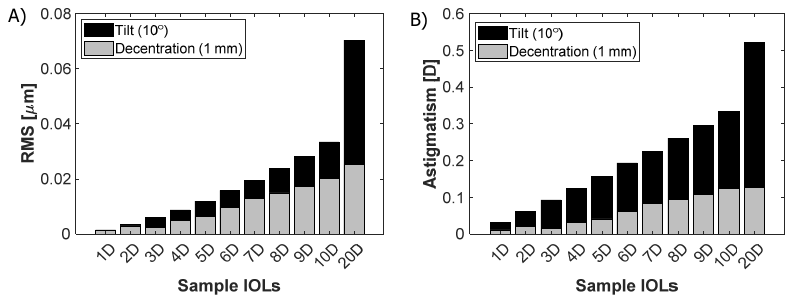
Figure 3. The root-mean-square (RMS) of the primary and secondary coma aberrations ( A ) and induced astigmatism ( B ) in the studied IOLs under isolated 10° tilt (black bars) and 1 mm decentration (gray bars) at a 3 mm aperture.